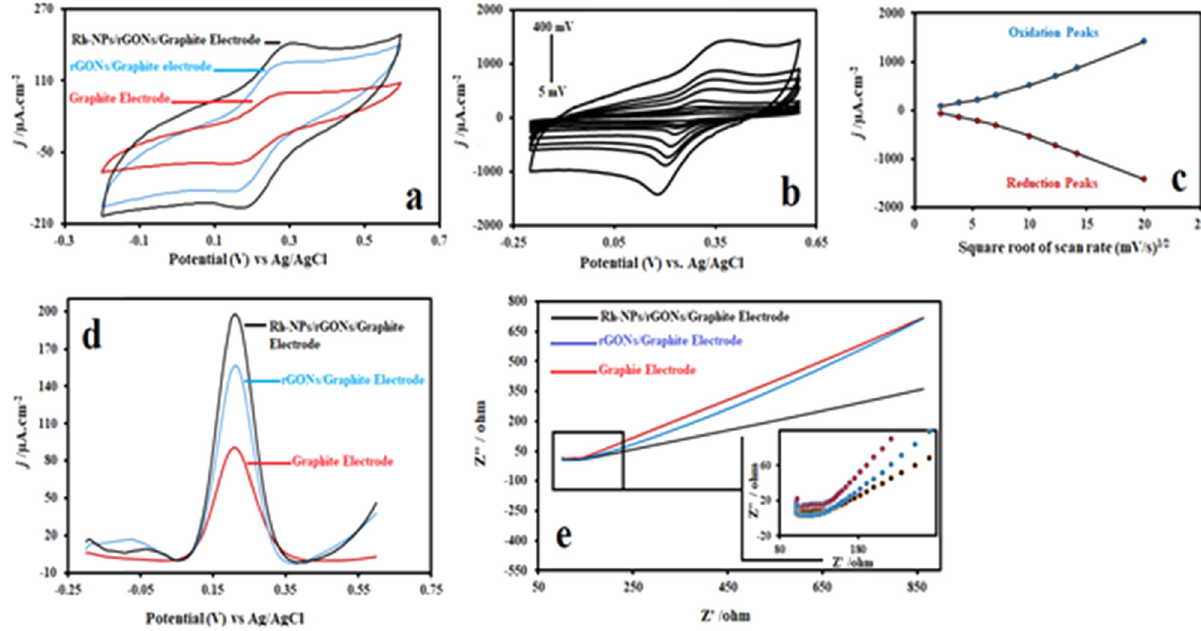
Figure 5: ( a ) Cyclic voltammograms of di ff erent bare and modi fi ed graphite electrodes, ( b ) CV graph characterization of Rh - NPs/rGONs/ graphite electrode based on various scan rates of 5, 15, 30, 50, 100, 150, 200, and 400 mV/s, ( c ) calibration curves of the redox peaks current density against the square root of the sweep rate based on cyclic voltammogram characterization of Rh - NPs/rGONs/graphite electrode, ( d ) DPV curves of di ff erent modi fi ed and bare graphite electrodes, and ( e ) EIS Nyquist plots of di ff erent modi fi ed and bare graphite electrodes in PBS containing 5.0 mM ferri - /ferro - cyanide ( 1:1 ) ion redox as an electrochemical